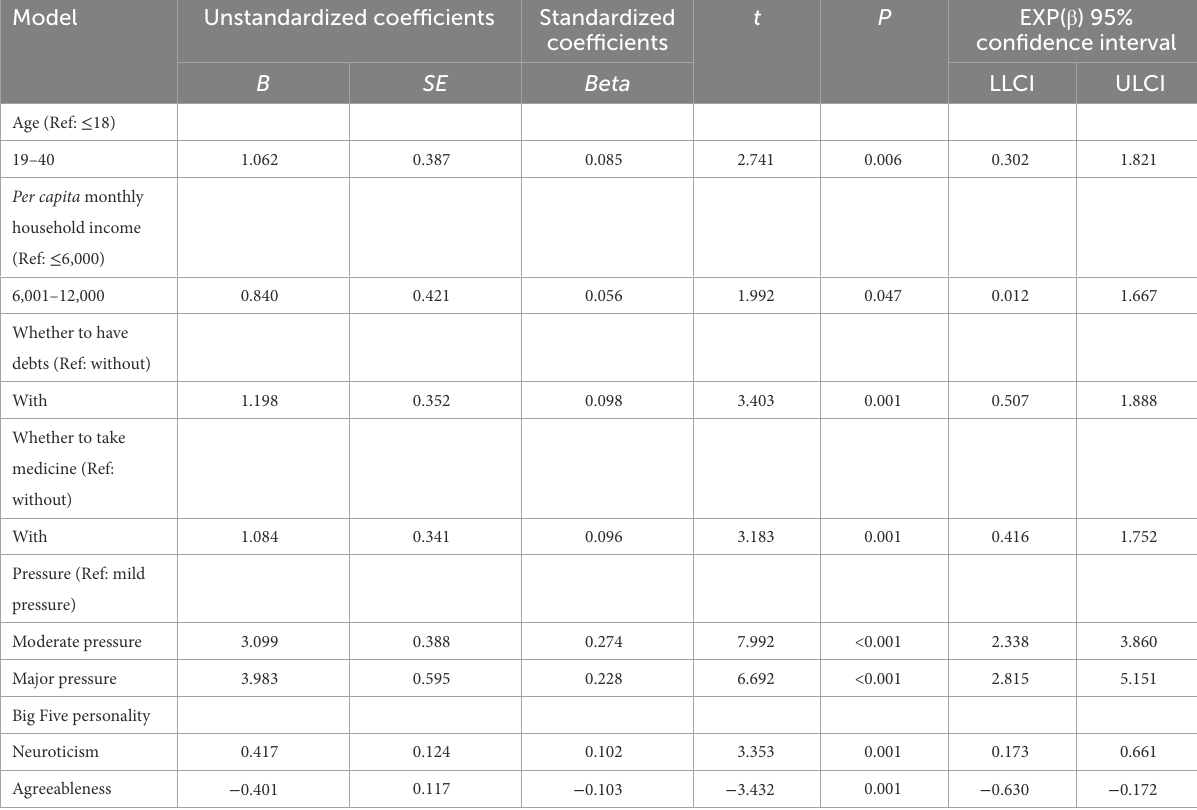
TABLE 5 Regression model analysis of depression in the media use low-frequency.